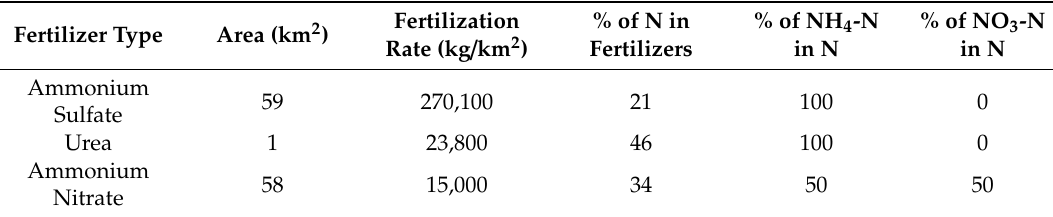
Table 2. The annual chemical fertilization in the study area. (Ministry of Agriculture, personal communication and unpublished reports, 2018).